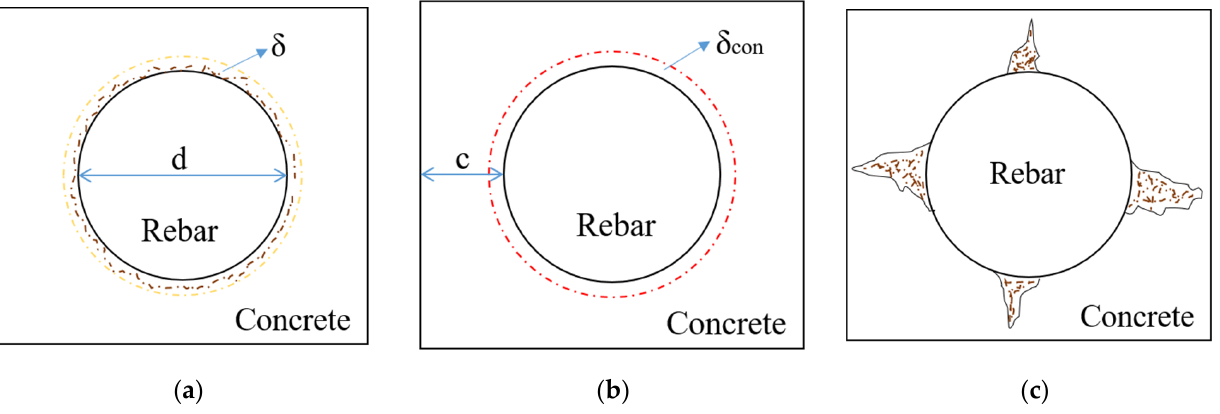
Figure 1. Basic structure of the spiral fiber sensor.